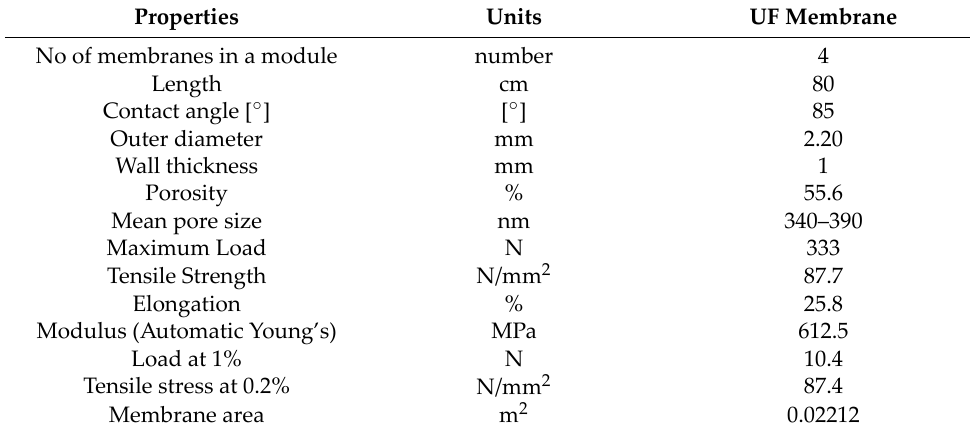
Figure 2. Experimental membrane modules used in the study; ( a ) UF membrane module used in hybrid MBBMR configuration, ( b ) MD membrane module used for submerged MD (Experiment 3), and ( c ) MD membrane module used for side stream MD (Experiment 1 and Experiment 2). Table 1. Properties of UF modules used in the